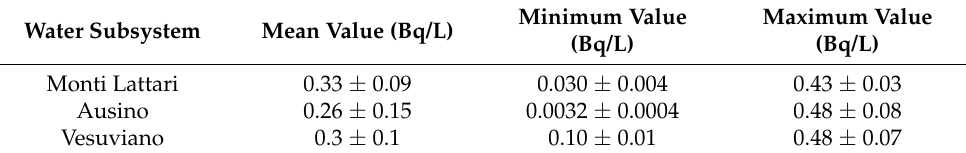
Table 7. Mean values of gross beta activity concentration for each water subsystem analyzed.